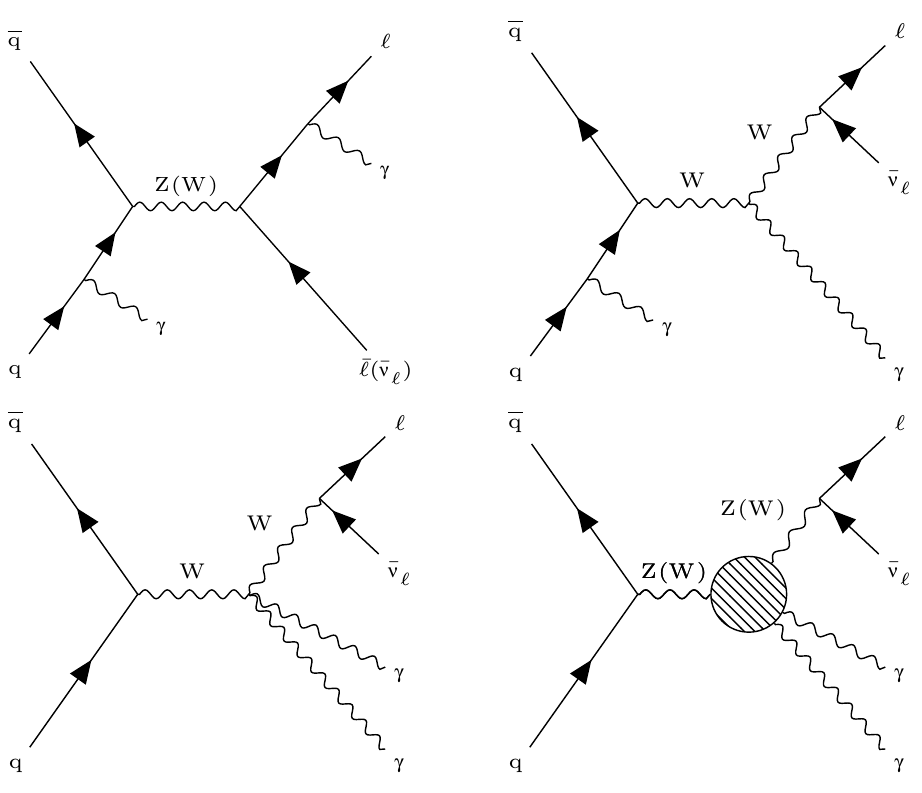
Figure 1 . Representative Feynman diagrams for the V gg production in the SM (top left, top right and bottom left) and beyond the SM (bottom